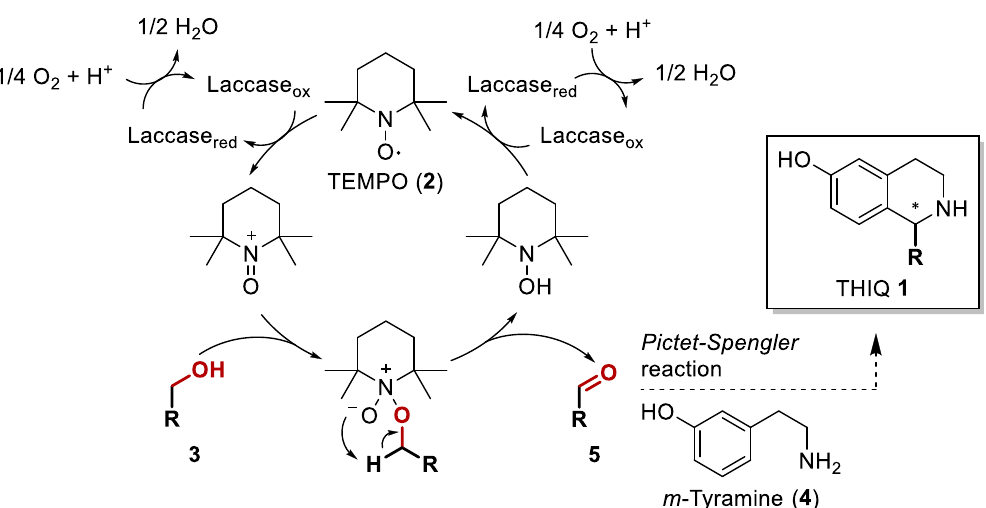
Scheme 2. Catalytic cycles of a laccase/TEMPO ( 2 ) system for the oxidation of primary alcohols to their corresponding aldehydes (adapted from Tromp et al.) [41]. THIQs 1 are formed by the consecutive Pictet–Spengler reaction with the amino alcohol m -tyramine ( 4 ).